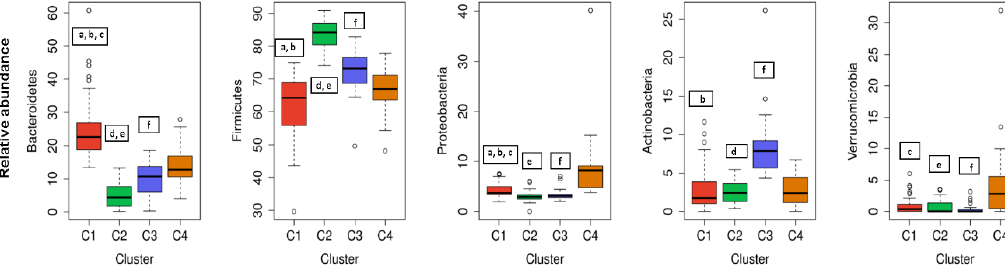
Figure 3. The cluster distribution of five most abundant bacterial phyla. Relative abundance per cluster of the five most abundant bacteria phyla present in our cohort. Each box shows the median plus interquartile range of the relative abundance of bacterial phyla. Colors show the cluster. Statistical significance differences ( p < 0.05) between clusters in each phylum are presented with symbols a, b, c, d, e, and f: a, statistical significance ( p < 0.05) between C1 and C2. b, statistical significance ( p < 0.05) between C1 and C3. c, statistical significance ( p < 0.05) between C1 and C4. d, statistical significance ( p < 0.05) between C2 and C3. e, statistical significance ( p < 0.05) between C2 and C4. f, statistical significance ( p < 0.05) between C3 and C4.